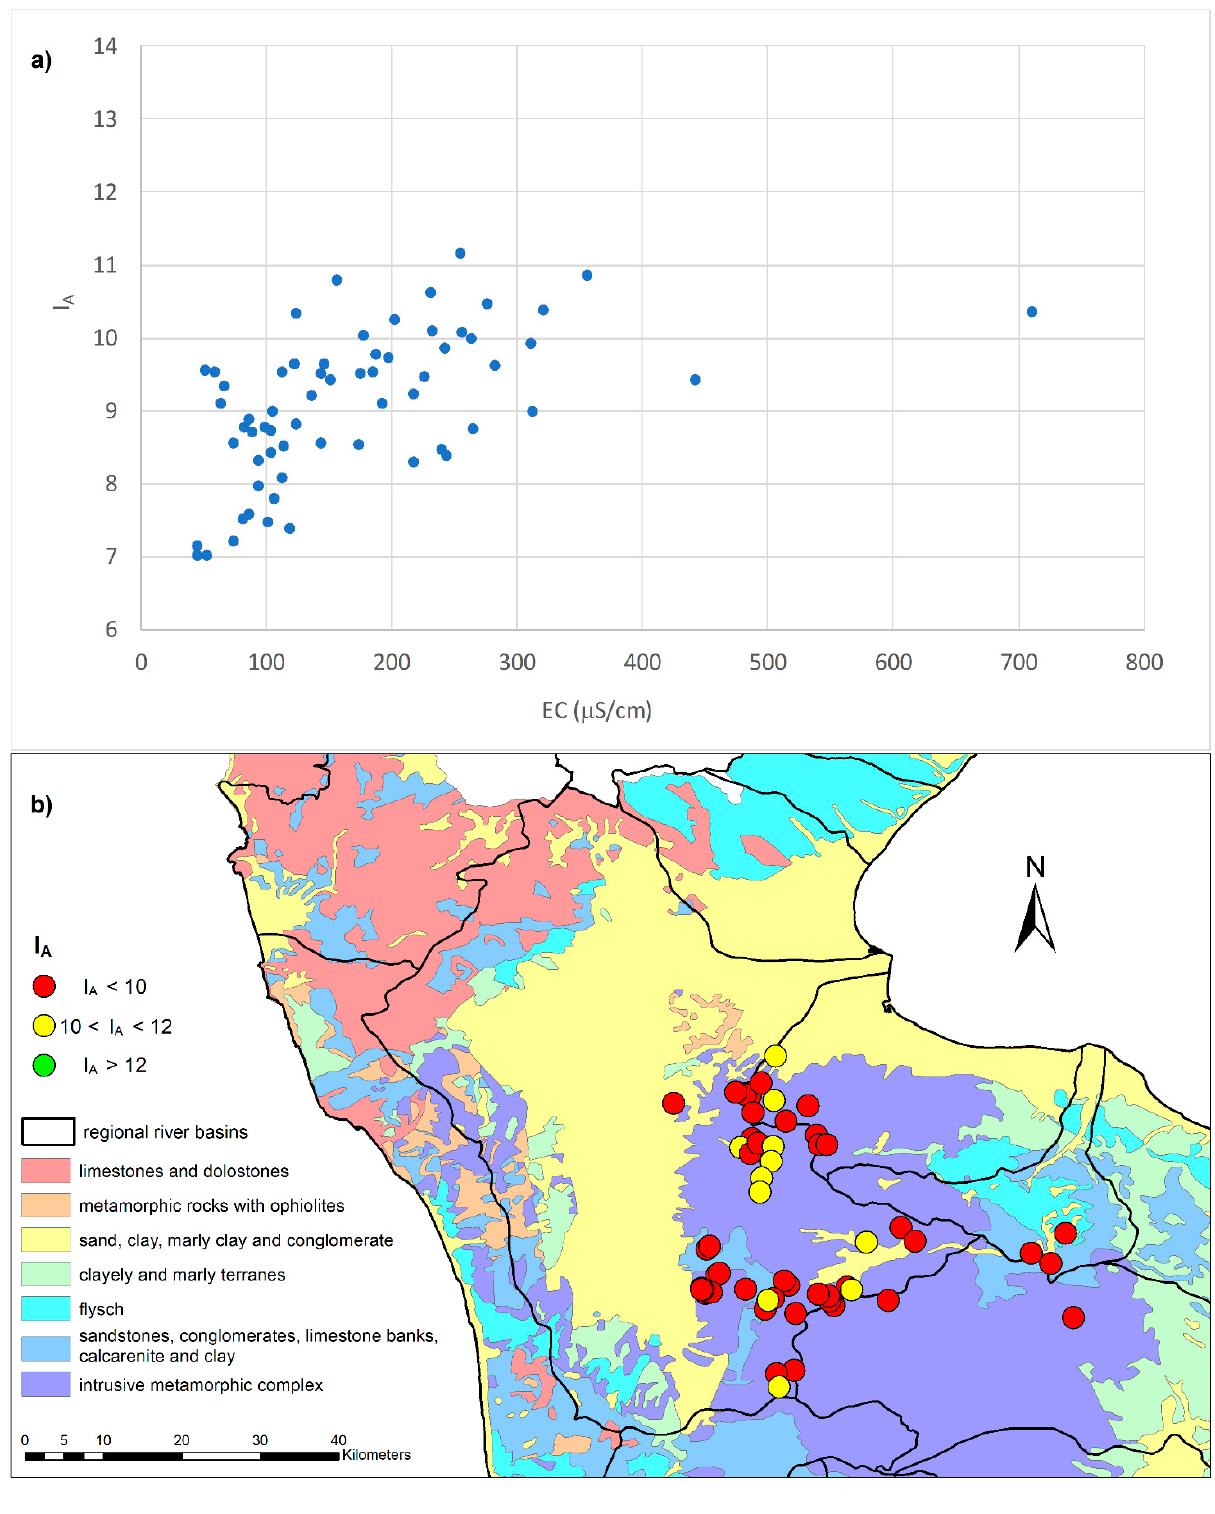
Figure 3. Bivariate plots of I A vs. EC ( a ) Bivariate plots of I A vs. EC and ( b ) I A classification of the spring waters according to geology.